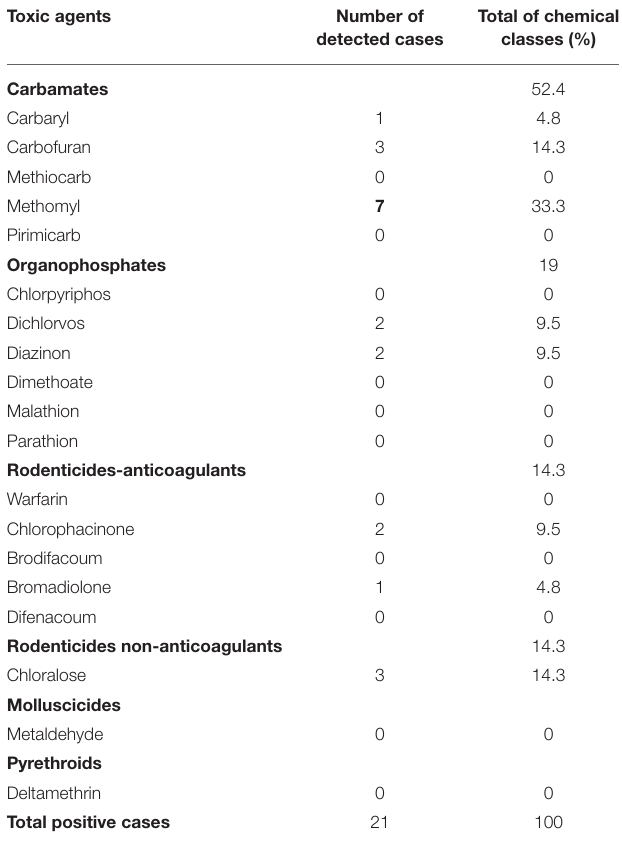
TABLE 2 | Pesticides implicated in animal poisoning and poisoned baits from 2014 to